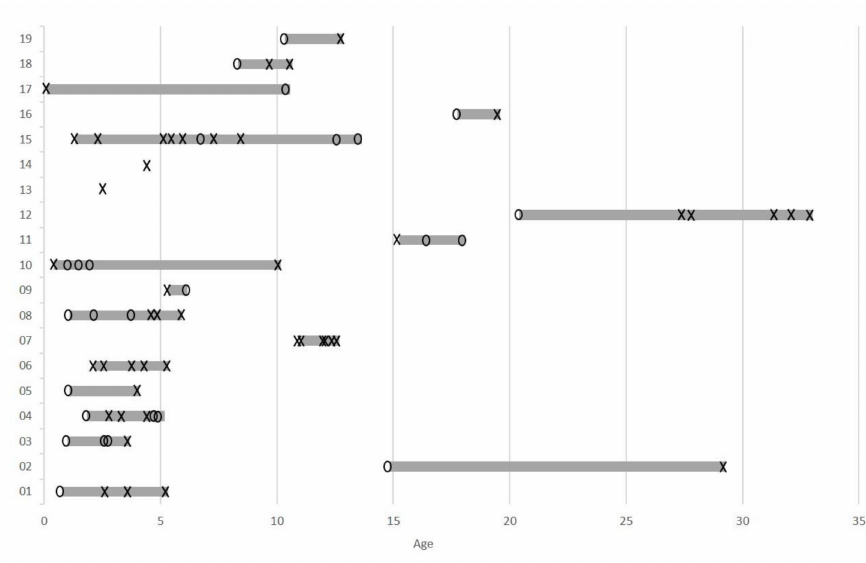
Figure 3. EEG recordings in the 19 patients with PWS and EEG paroxysmal abnormalities. 0 = normal EEG; X = abnormal EEG.